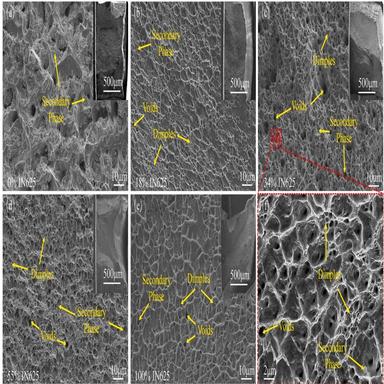
Fracture morphologies of the FGM. (a – e) Fracture morphology of the FGM with different contents of IN625, (f) high magnetization of the box area with dash line in.